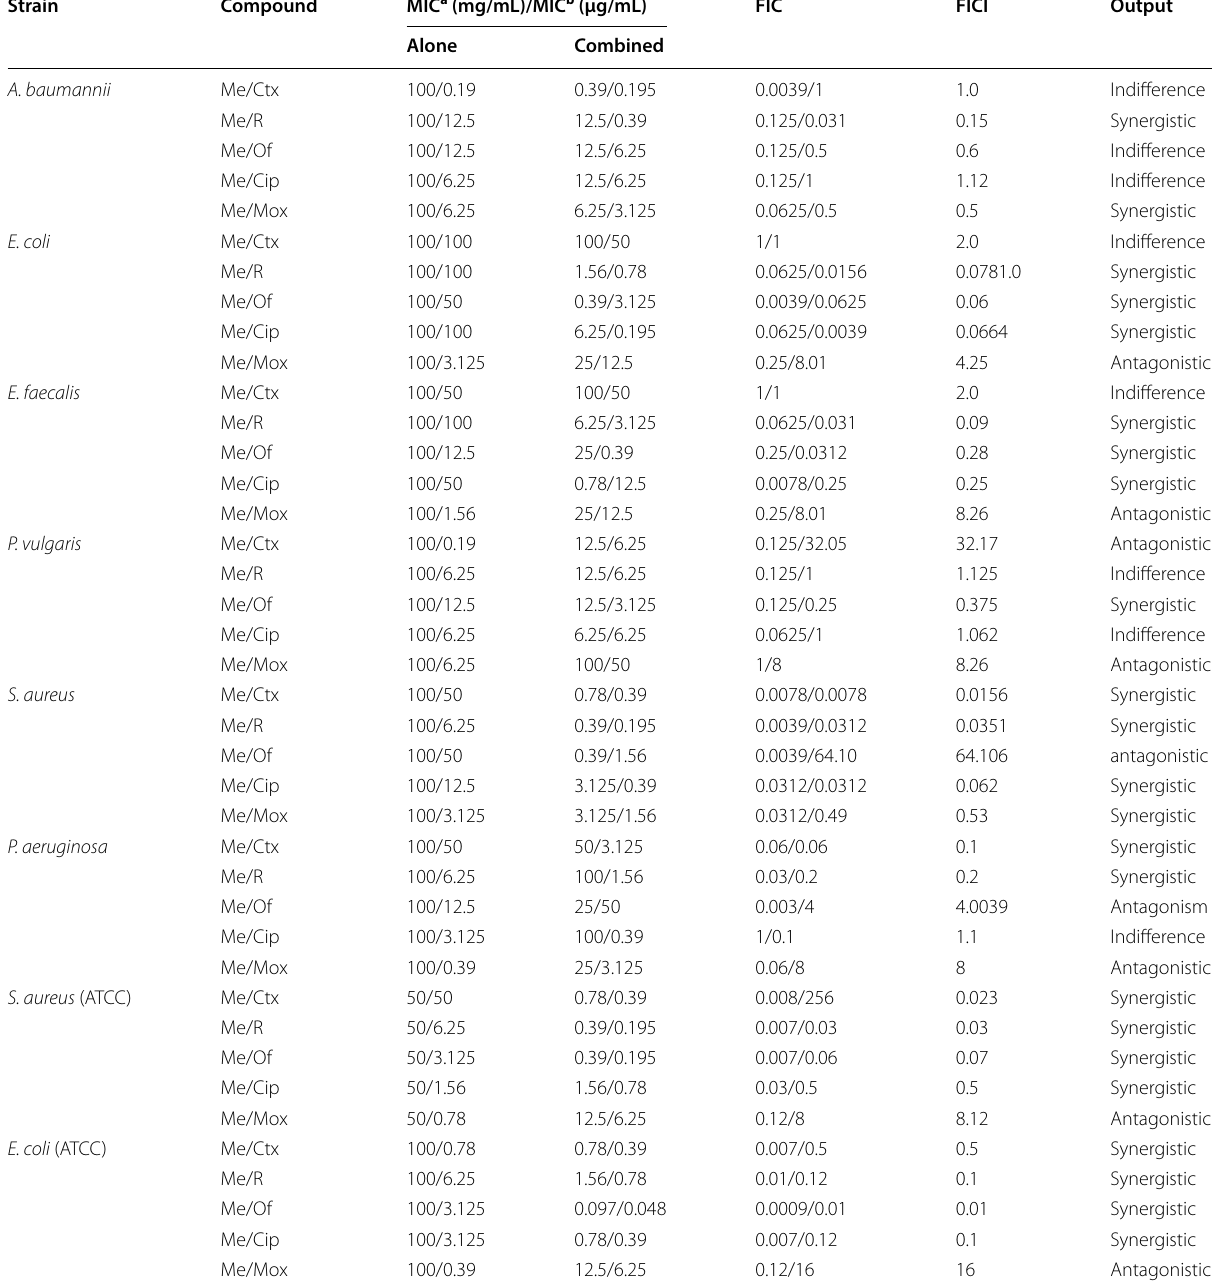
MIC a minimal inhibitory concentration for methanolic extract when applied alone, MIC b minimal inhibitory concentration for antibiotic when applied alone, Me methanolic extract, Ctx cefotaxime, R rifampicin, Of ofloxacin, Cip ciprofloxacin, Mox moxifloxacin, ND not determined